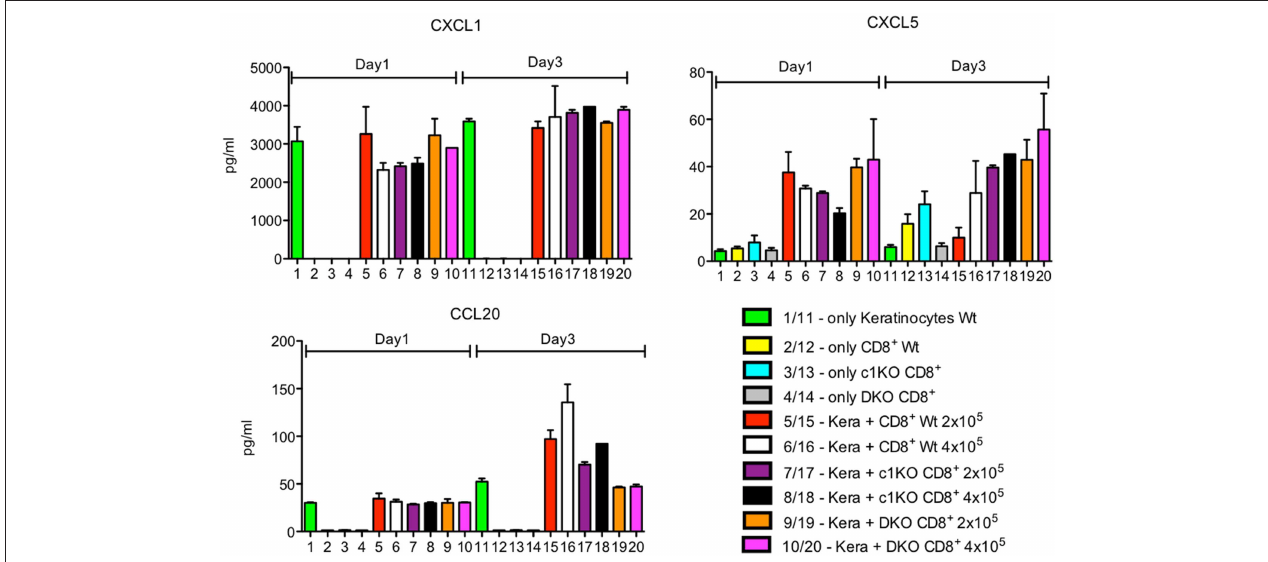
FIGURE 2 | Secretion of chemokines CXCL1, CXCL5 and CCL20 by keratinocytes alone or upon co-culture with CD8 + T cells. Keratinocytes cultured for 7 d in vitro and splenic CD8 + T cells pre-activated by α CD3/CD28 Ab for 1 d were either cultured alone or together in 6-well plates for 1 or 3 d as indicated and their chemokine secretion